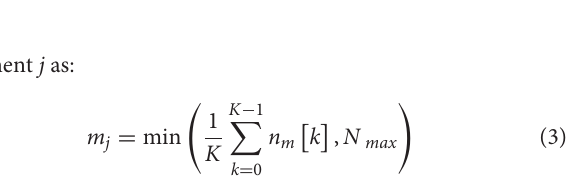
FIGURE 2 | Sample videosomnography frame (A) and the corresponding selected infant/toddler area (B) . w p and h p are the width and height of the resized image. N max is the maximum number of pixels allow to “ move ” within the